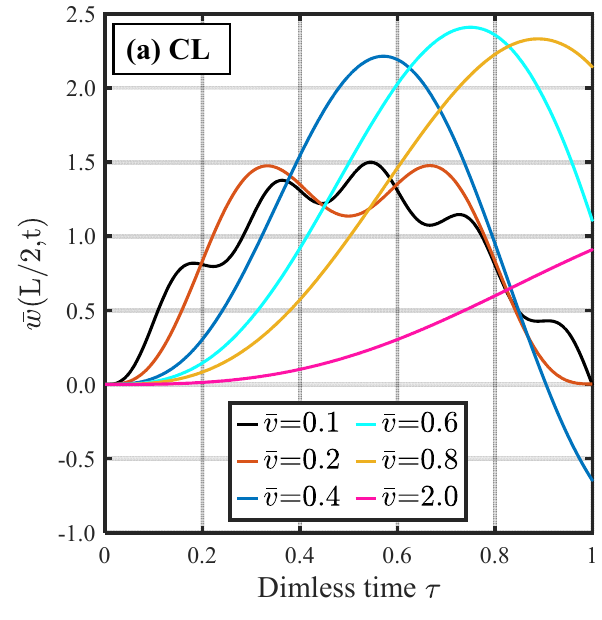
Figure 9. Influence of the dimensionless velocity on the variation in the dimensionless central de ‐ flection vs. the dimensionless time under a uniform moving load based on CL and CS formulations ( Δ(cid:1846) (cid:3404) 80, (cid:1838)(cid:1846)(cid:1844) , (cid:1863) (cid:3051) = (cid:1863) (cid:3053) = 0.2). 7. Conclusions A dynamic response in closed ‐ form solutions for sigmoid bidirectional functionally graded microbeams excited by a moving harmonic mechanical load under a thermal en ‐ vironment was developed by considering the microstructure effect. Temperature